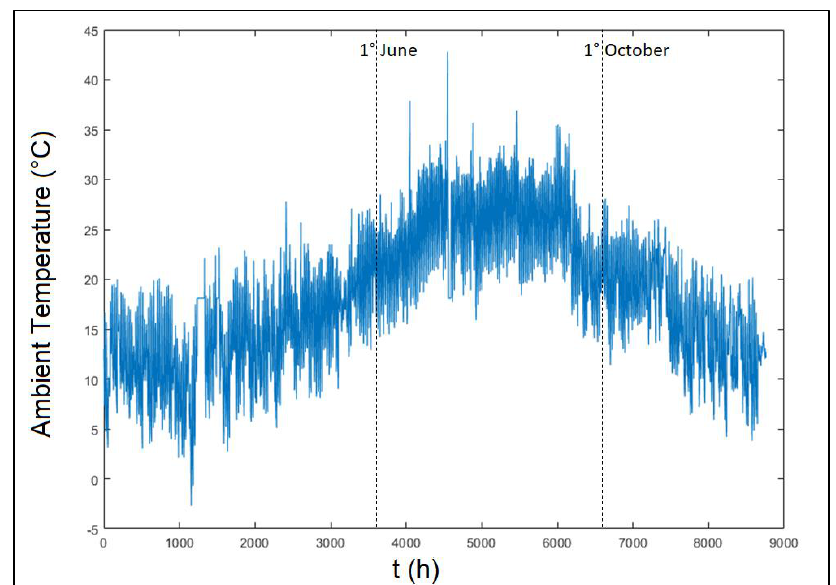
Figure 11. Ambient temperature used as input of the SHyFTA model.